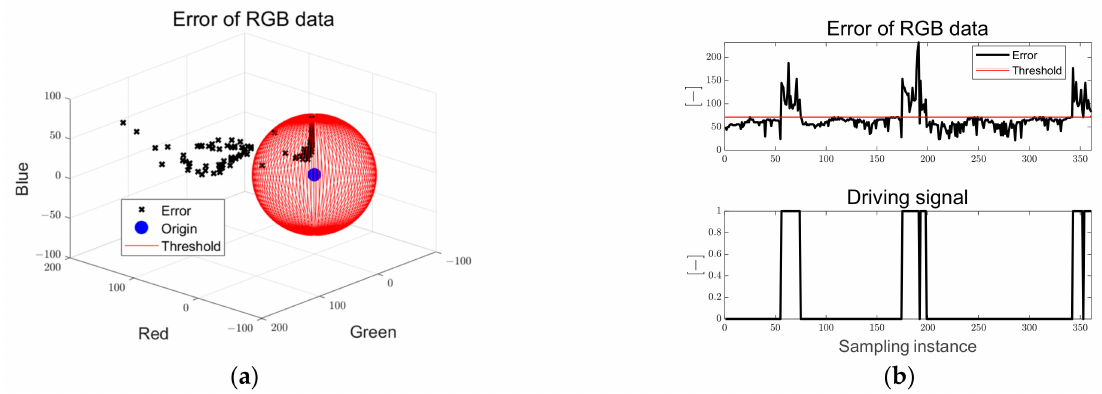
Figure 19. S-curved path tracking scenario results; ( a ) error of RGB data; ( b ) driving flag signal.